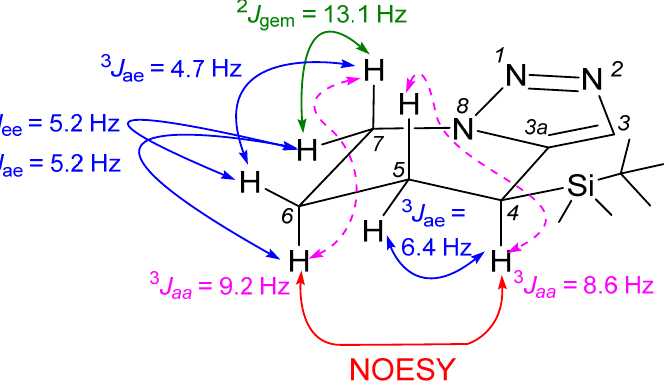
Figure 2. Observed coupling constants ( 1 H NMR, C 6 D 6 ) and NOESY effects of compound 4 . Table 1. Characteristic NMR shifts of the fused core of product 4 and their comparison with published data [5,13] for unsubstituted 4,5,6,7-tetrahydro-[1,2,3]triazolo[1,5-a]pyridine. Compound